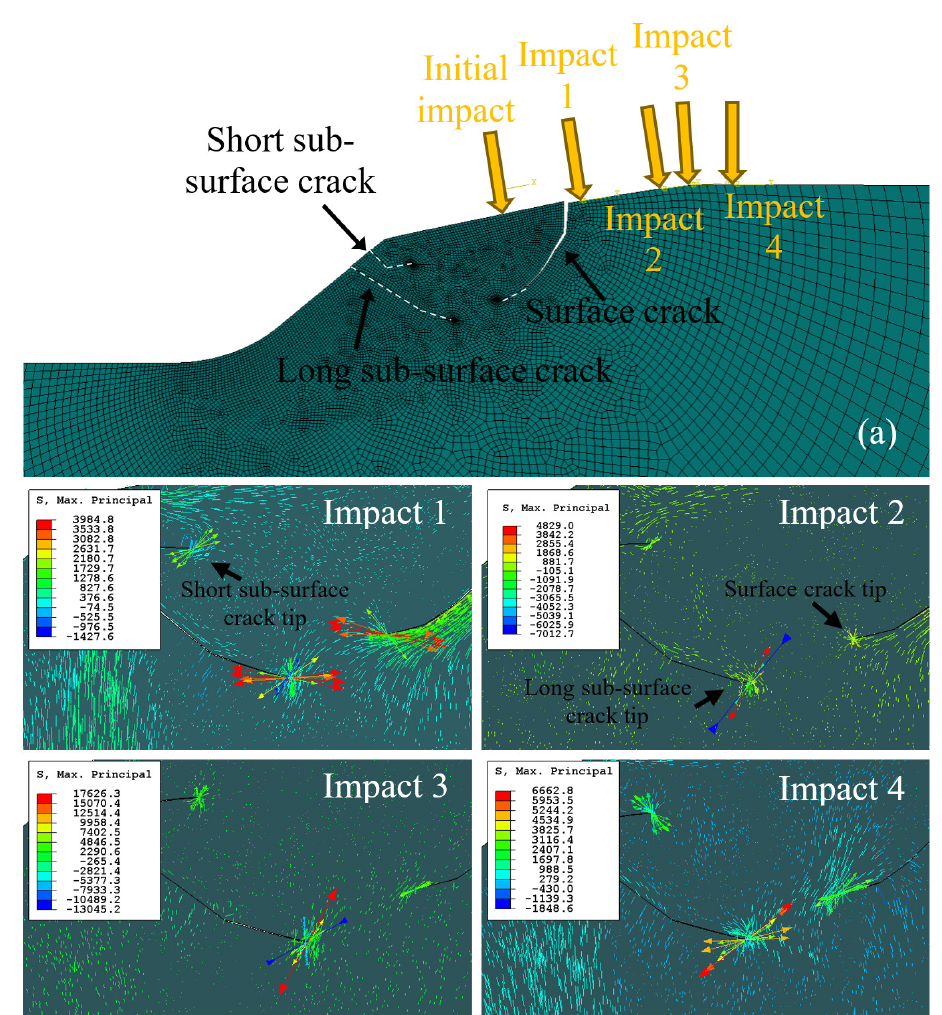
Figure 9. Residual maximum principal stress direction and magnitude following an RE impact at four locations. The impact locations are indicated in Figure ( a ). The crack tips are distinguished by the finer mesh. Red arrows indicate tensile stresses, and blue arrows indicate compressive stresses.